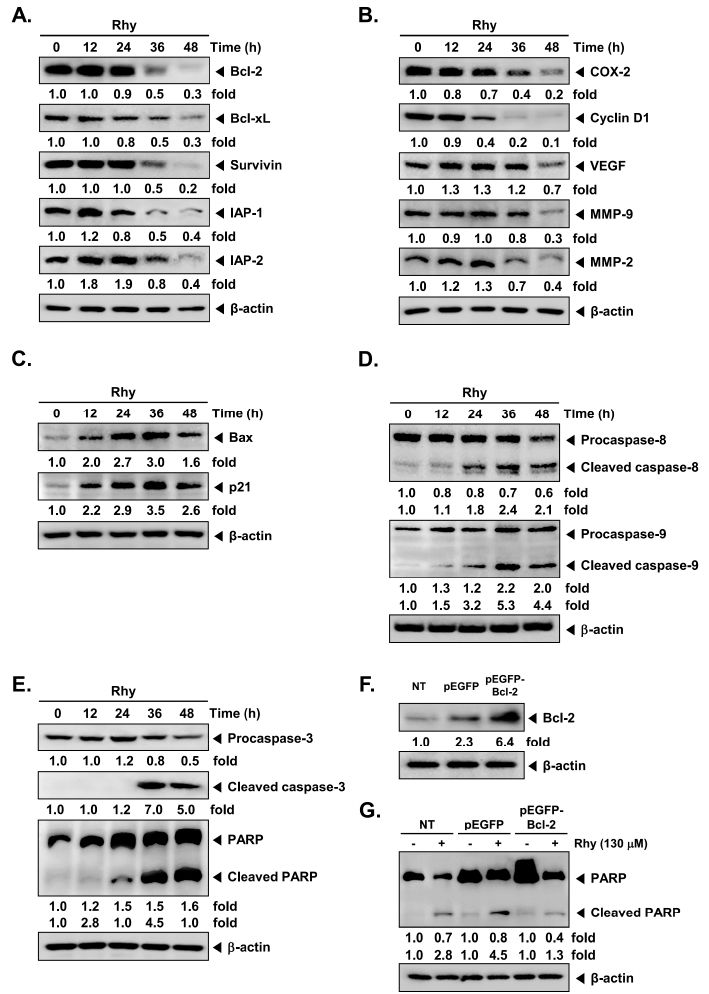
Figure 2. Induction of apoptosis by Rhy in HepG2 cells. ( A – C ) Rhy modulates expression of various proteins involved in anti-apoptosis, proliferation, angiogenesis, metastasis, and pro-apoptosis. HepG2 cells (1 × 10 6 cells/well) were incubated with Rhy (130 µM) for 0, 12, 24, 36, and 48 h. Whole-cell extracts were prepared, and 20 µg of the whole-cell lysate was resolved by sodium dodecyl sulfate polyacrylamide gel electrophoresis (SDS-PAGE), electrotransferred to nitrocellulose membrane, sliced from the membrane based on the molecular weight, and then probed with antibodies against Bcl-2, Bcl-xL, survivin, inhibitors of apoptosis protein (IAP)-1/2, COX-2, Cyclin D1, VEGF, MMP-9/2, Bax, and p21 as described in the Materials and Methods. The same blots were stripped and reprobed with β -actin antibody to verify equal protein loading; ( D , E ) HepG2 cells (1 × 10 6 cells/well) were treated with Rhy (130 µM) for 0, 12, 14, 36, and 48 h. Thereafter, equal amounts of lysates were analyzed by Western blotting analysis using antibodies against caspase-8/9/3 and PARP. The same blots were stripped and reprobed with β -actin antibody to verify equal protein loading; ( F ) Cells were transiently transfected with pEGFP-Bcl-2 or pEGFP (control vector) plasmid. Bcl-2 protein was overexpressed in pEGFP-Bcl-2 transfected HepG2 cells compared with control. The results shown are representative of the three independent experiments; ( G ) Transiently transfected cells were treated with Rhy for 48 h. Thereafter, equal amounts of lysate were analyzed by Western blot analysis using antibodies against PARP and β -actin.